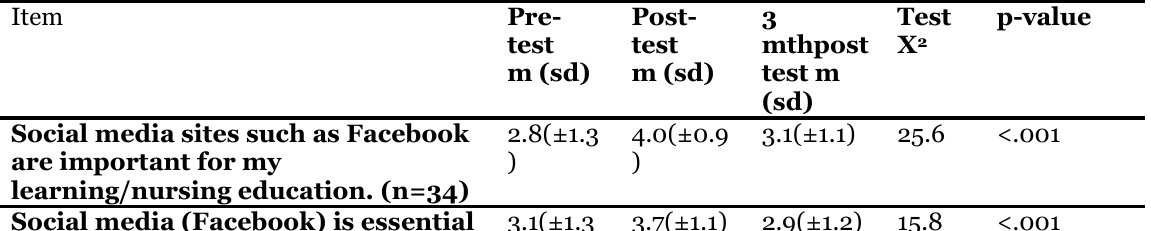
Pre, Post, and Three-Month Post Evaluation of Perceived Values of